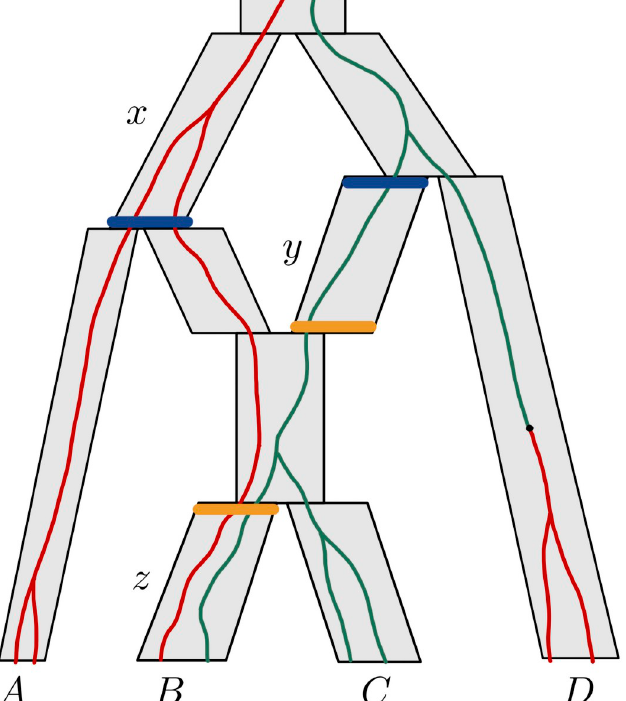
Fig 2. Illustration of the concepts and notation employed to describe likelihood computations. The species network topology is the same as that in Fig 1, but branches (populations) are now represented as grey parallelograms. A gene tree is drawn inside the species network (green and red lines). One mutation occurs in the branch above D . We focus on three branches: x , y and z . Colored horizontal bars represent the population interfaces x , y , y and z . Note that ð x ; y Þ (blue) is a vector of incomparable population interfaces, while ð y ; z Þ (orange) is not, as z is a descendant of y . Here, n n B = n C = n D = 2, r A = 2, r B = 1, r C = 0, r D = 2 are known, whereas the values of N observed, and depend on the gene tree generated by the MSNC process. For the gene tree shown, N ¼ ð 2 ; 0 Þ . Since z is incident to leaf B , we have z ¼ B and R R ð x ; y Þ ðð n ; n 0 Þ ; ð r ; r 0 ÞÞ ¼ P ð R F ð x ; y Þ